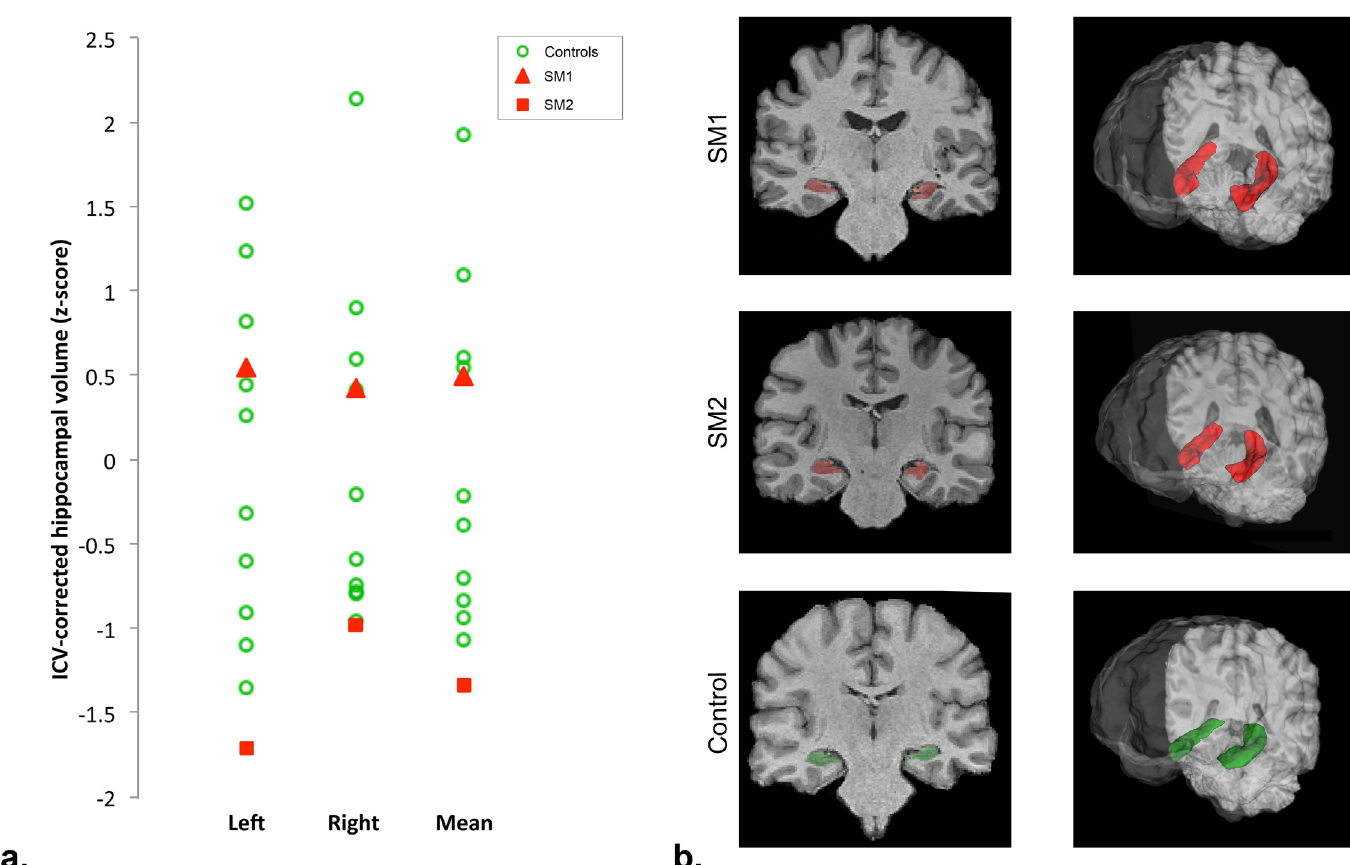
Fig 1. Hippocampus volumetry in SMs and controls. a. ICV-corrected hippocampal volumes of SMs and controls. Z-scores were calculated based on means and standard deviations of 10 control participants. b. Hippocampi of SM1 and SM2 (red) and one representative control subject (green) displayed on a coronal slice, as well as in